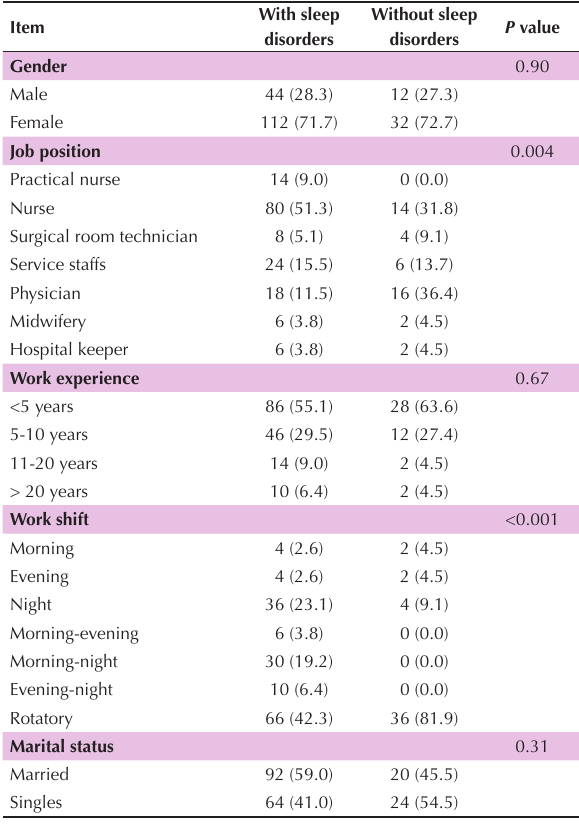
Table 2. Prevalence of sleep disorders based on characteristics